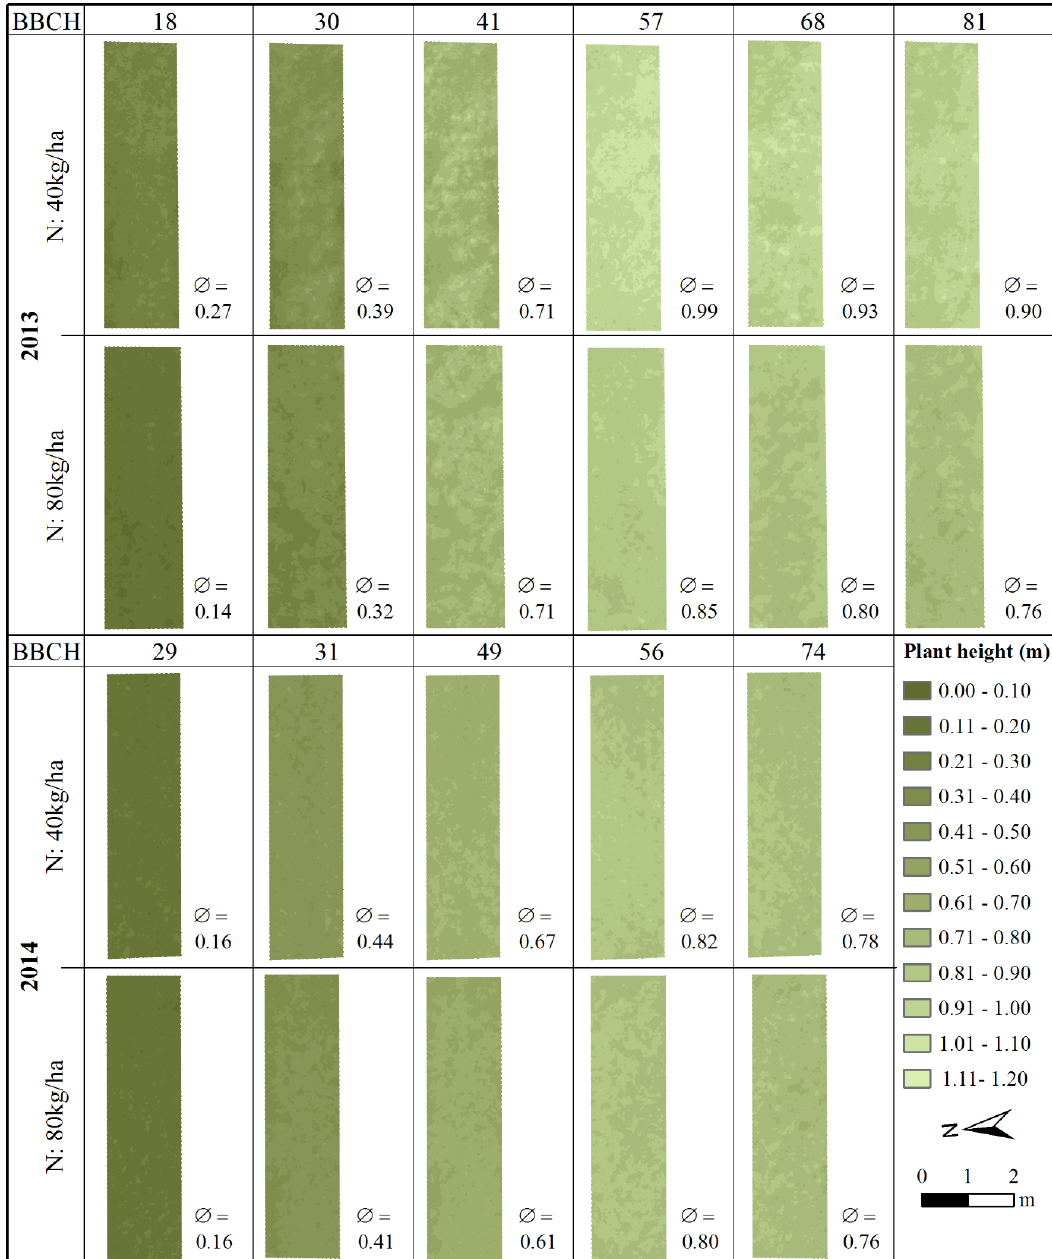
Figure 3. Maps of four plots from the last six and five campaigns of 2013 and 2014, respectively. One plot of each N fertilizer level of the barley cultivar Trumpf is shown for each year (  : Plot mean